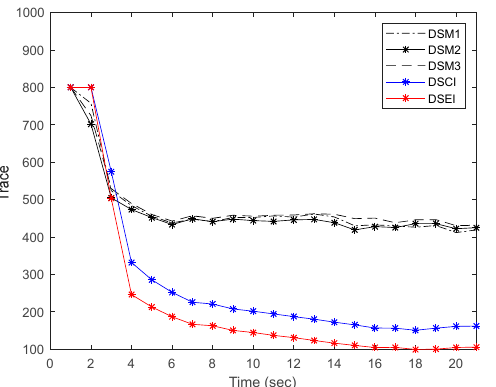
Figure 6. Comparison of the estimated ellipsoid size of the local DSM estimator with the DSCI and DSEI estimators.